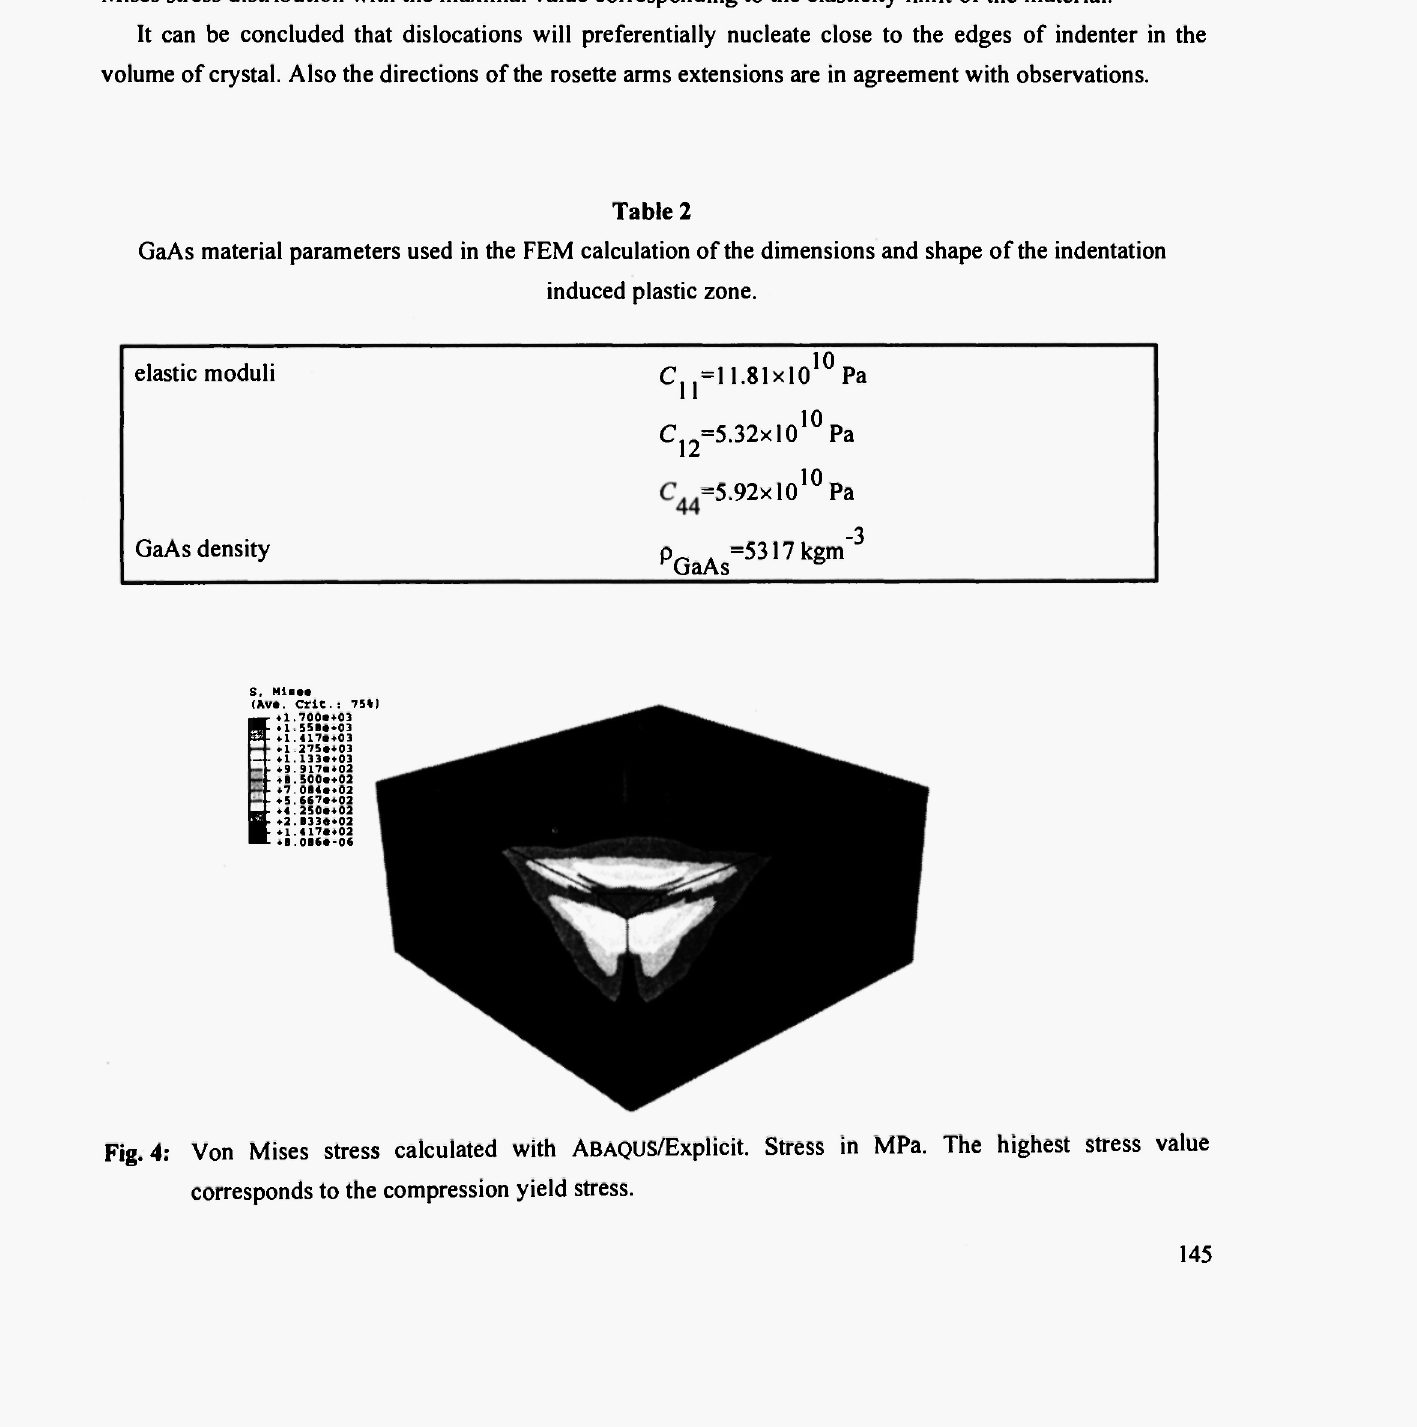
GaAs material parameters used in the FEM calculation of the dimensions and shape of the indentation induced plastic zone.